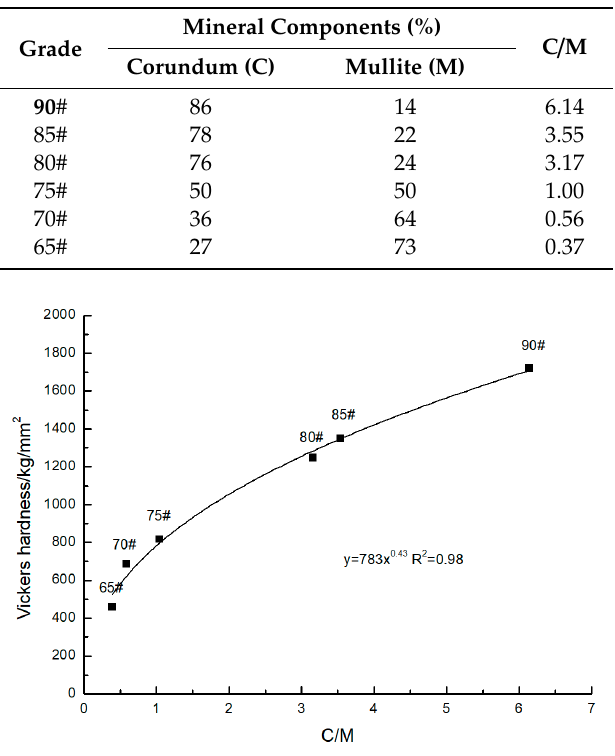
Figure 8. The relationship between C/M and Vickers hardness.